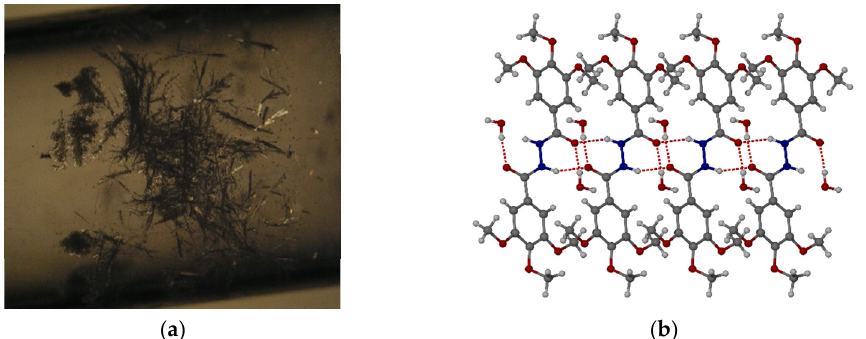
Figure 3. ( a ) Crystals of G2 from ethanol. ( b ) Crystal packing in the dihydrate of G2 crystallized